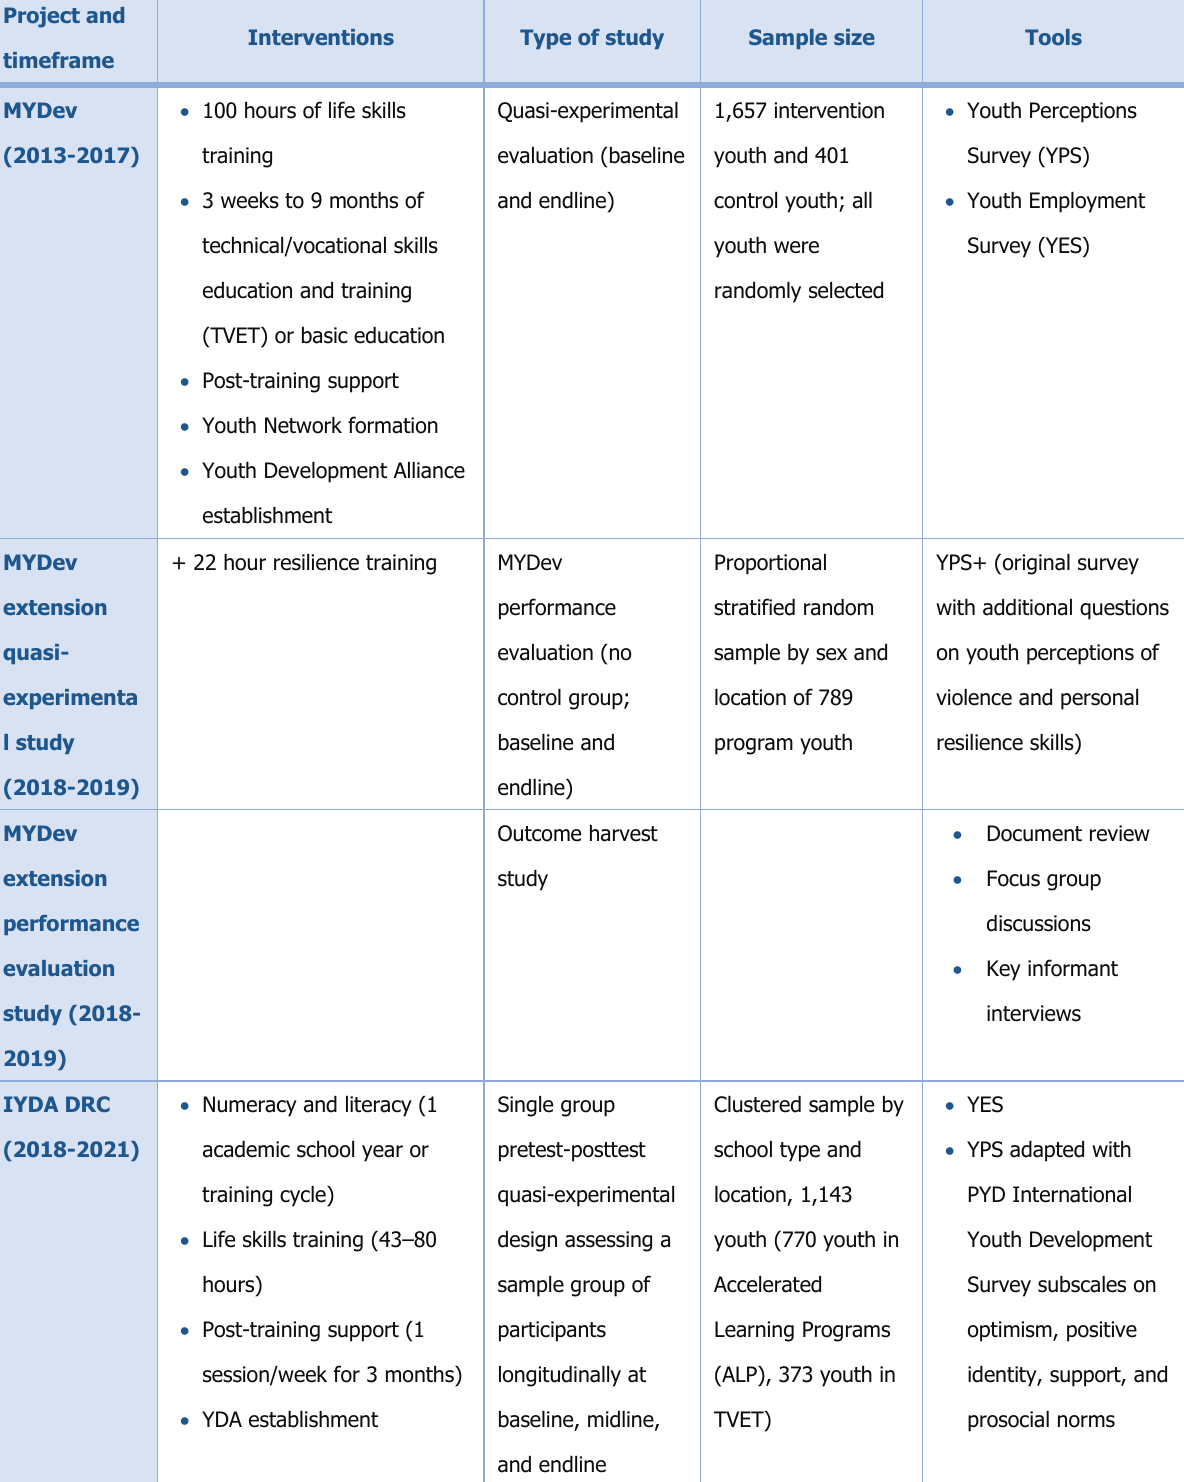
Table 2. MYDev and IYDA Case Studies at a Glance Project